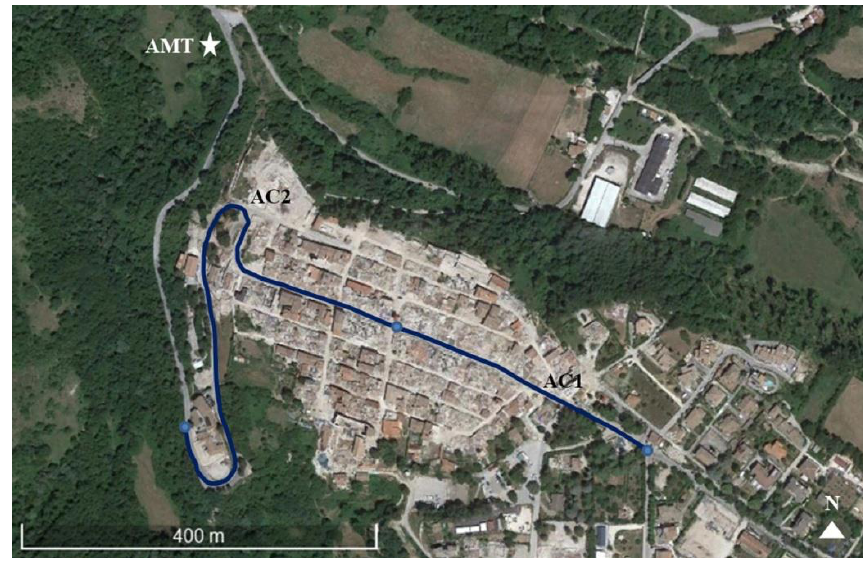
Figure 11. Location of Amatrice (AMT) seismic station and road network segments individuation.